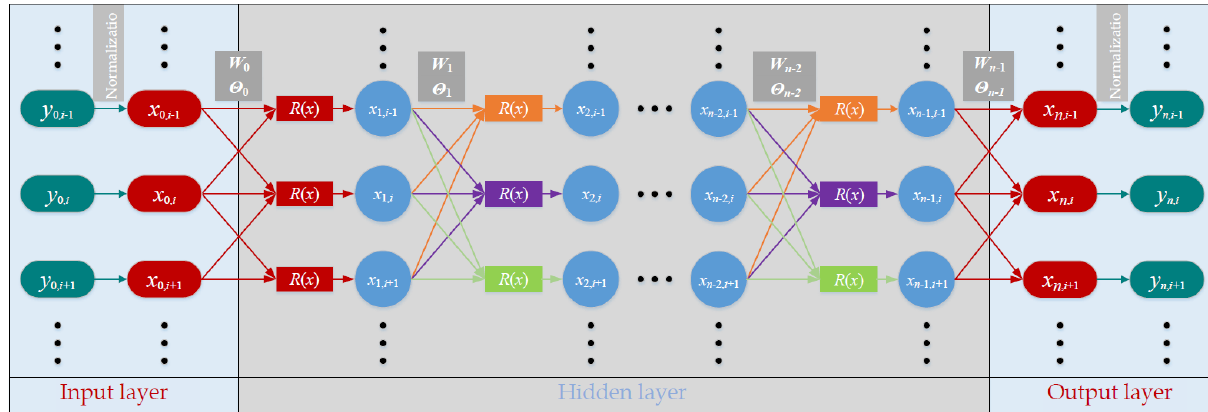
Figure 9. Structure of the artificial neural network.